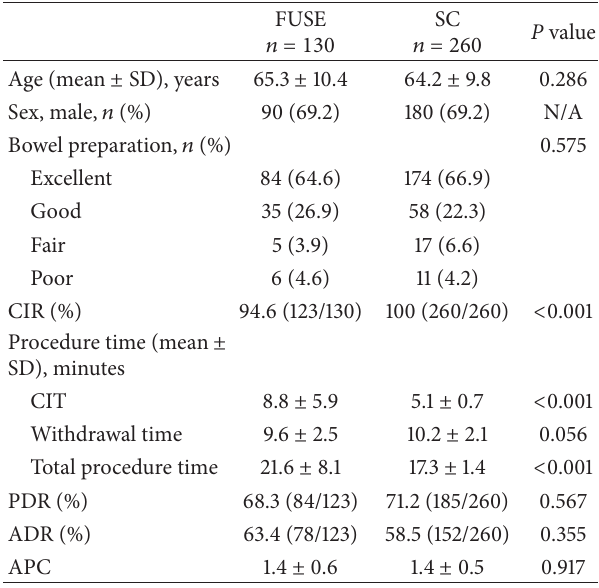
Table 1: Comparison of procedure outcomes in FUSE colonoscopy and